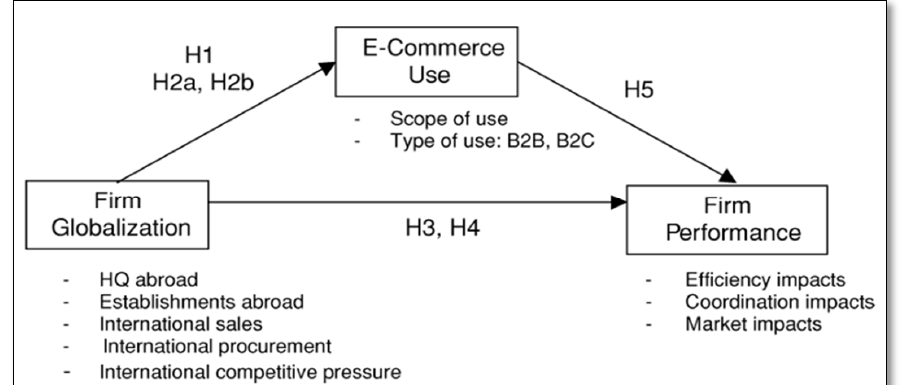
Figure 2. Corporate globalization and e-commerce performance [53].